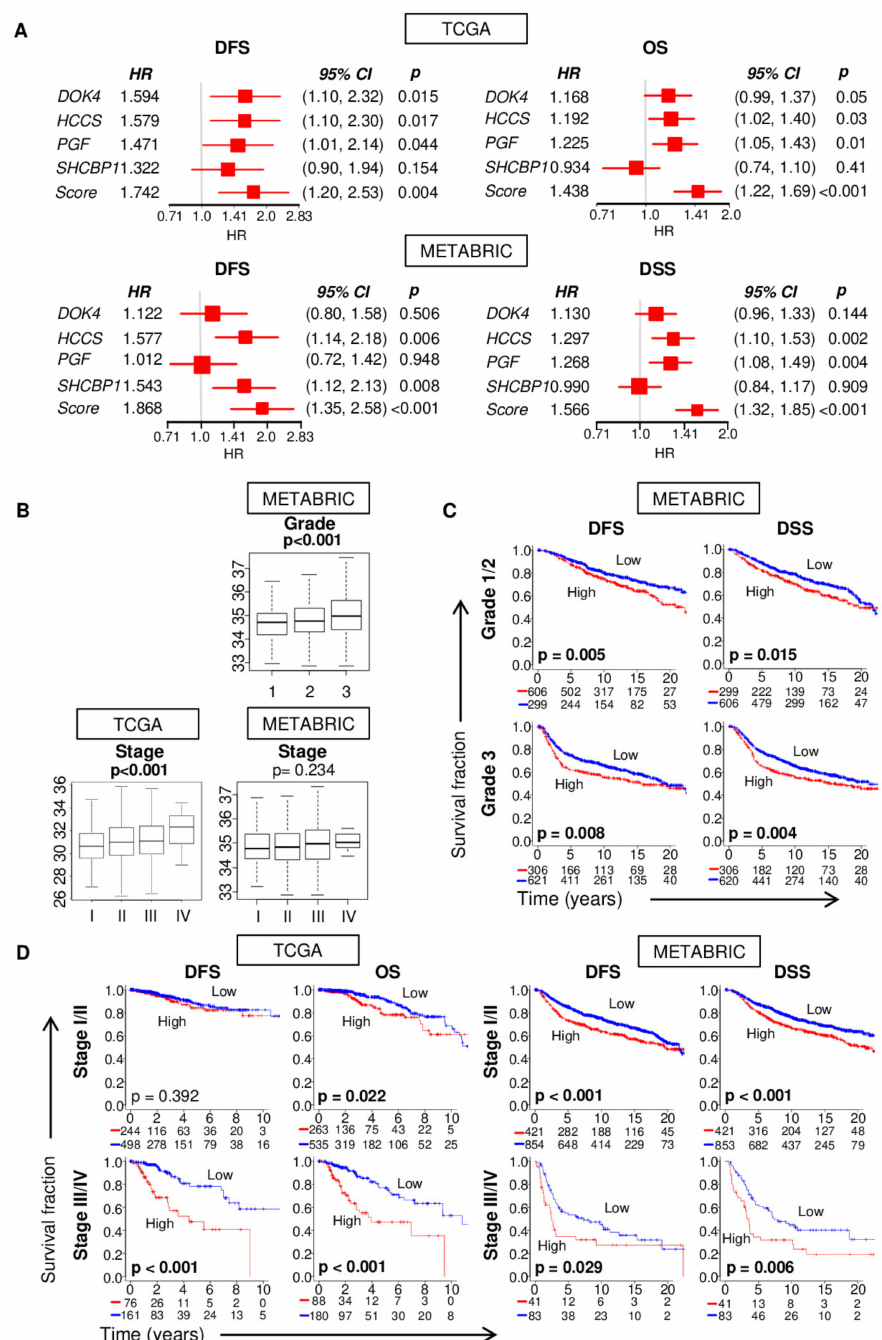
Figure 1. Patients with a high 4-gene score had poor survival and aggressive clinical parameters in two breast cancer cohorts. ( A ) Disease-free survival ( DFS ), and overall ( OS ) or disease-specific ( DSS ) survival in TCGA and METABRIC cohorts along with hazard ratios ( HR ) and their 95% confidence intervals and p -value are shown for the score and individually for each of its constituent genes. ( B ) Boxplots of 4-gene scores of tumors of di ff erent Nottingham pathological grades and American Joint Committee on Cancer (AJCC) stages. All plots are of Tukey type and boxes depict medians and inter-quartile ranges. p values were calculated with one-way ANOVA test. ( C , D ) Kaplan–Meier plots with logrank test p values are shown for association between the 4-gene score with DFS and OS or DSS for di ff erent grades and stages. Within-cohort one-third percentile value of the 4-gene score or expression of individual genes was used to classify patients into low and high